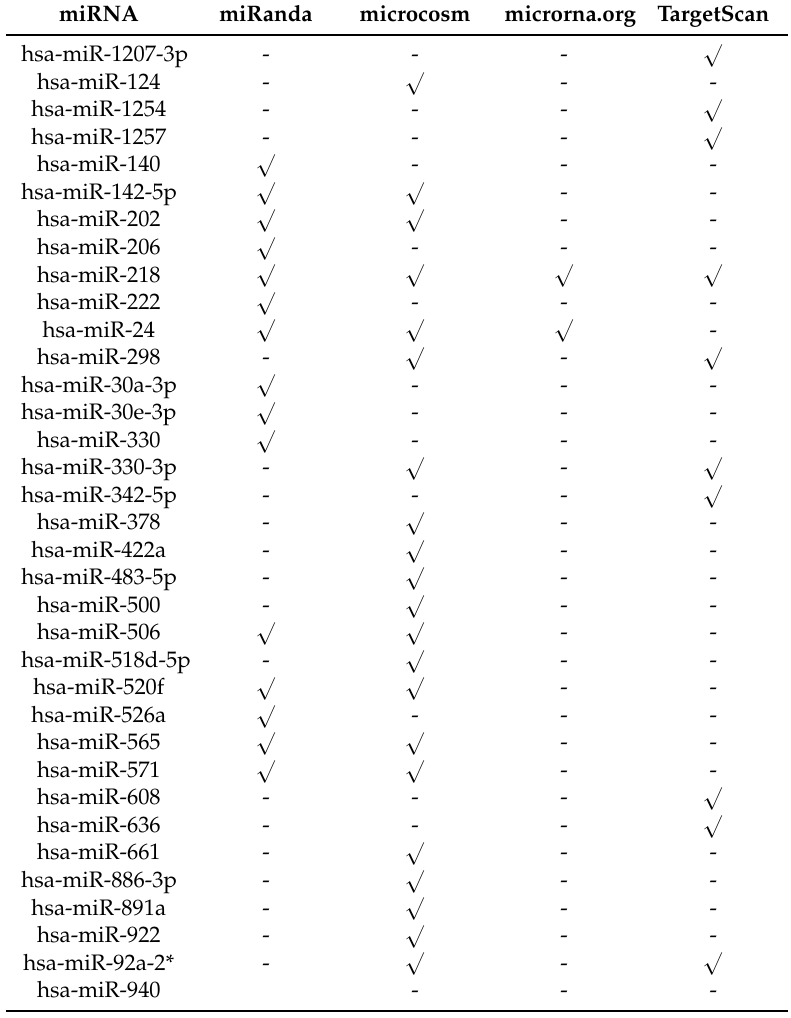
Table 1. miRNAs targeting ALAS2 predicted by online miRNA